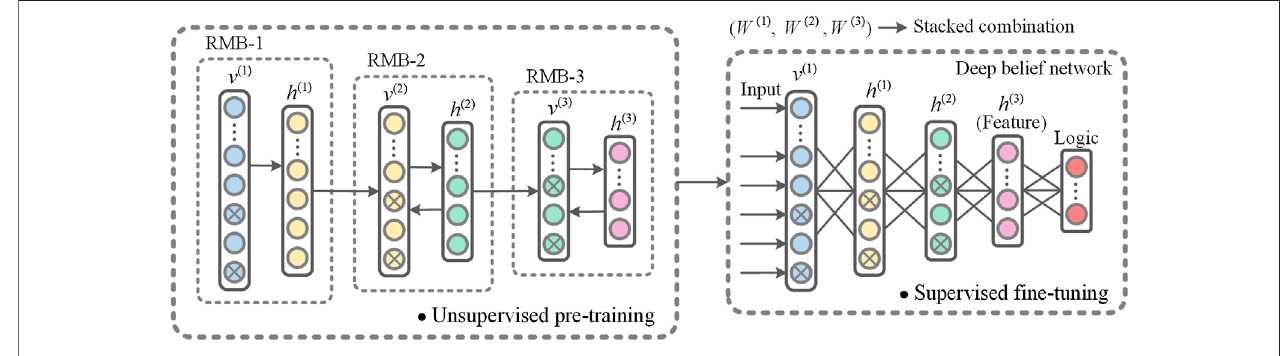
FIGURE 2 | Deep belief network